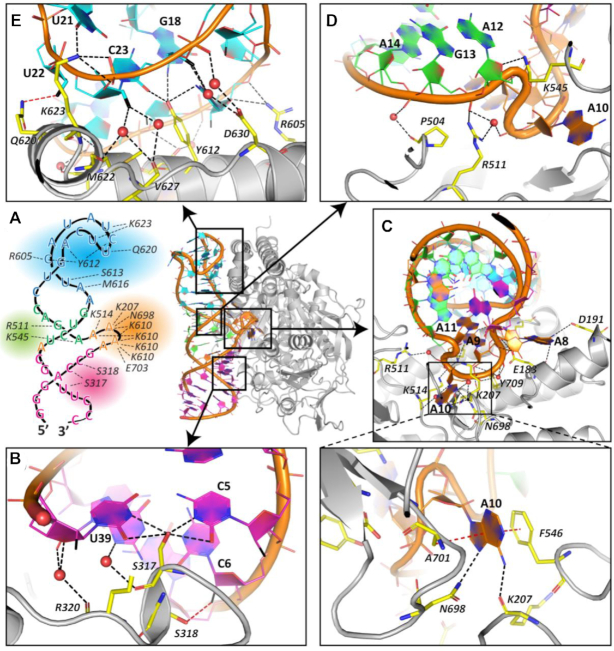
Structural characterization of the PSMA/A9g complex. The A9g backbone is shown as an orange ribbon, nucleotides are represented by lines with filled-in rings and are color-coded based on the secondary structure assignment – S1 stem (magenta), L1 loop (orange), S2 stem (green) and L2 loop (cyan). Hydrogen bonds are shown as dashed lines, water molecules as red spheres. (A) A schematic 3D representation of A9g together with amino acids involved in direct hydrogen-bonding interactions with PSMA (left) and a structural ‘preview’ of the PSMA/A9g complex (right). (B) Detailed view of the S1 stem interaction interface. S317 (yellow stick) is the key PSMA-interacting residue bridging nucleobases of C5 and U39. Also shown is a noncanonical hydrogen bond between the C6 fluorine atom (black) and the S318 hydroxyl group (red dashed line). (C) The L1 loop is flipped out of the double helical secondary structure of the S1 and S2 stems. The A10 nucleobase is inserted into the entrance funnel of PSMA, where it is stacked between side chains of F546 and A701 and furthermore is hydrogen-bonded to the carbonyl oxygen of K207 and the side chain amide of N698. It should be noted that N698 and A701 are part of the glutarate sensor, a flexible amino acid segment critical for substrate recognition. (D) Limited S2-PSMA interface is formed by two direct and two water-mediated H-bonds. (E) The L2 hairpin loop interacts extensively with residues of the C-terminal domain of PSMA. A wide network of hydrogen bonds is shown by dashed lines and residues Y612, K623 and R605 contribute with 8 of 10 total direct hydrogen bonds. A noncanonical hydrogen bond between the U22 fluorine atom (black) and the Q620 side chain amide is shown as a red dashed line.